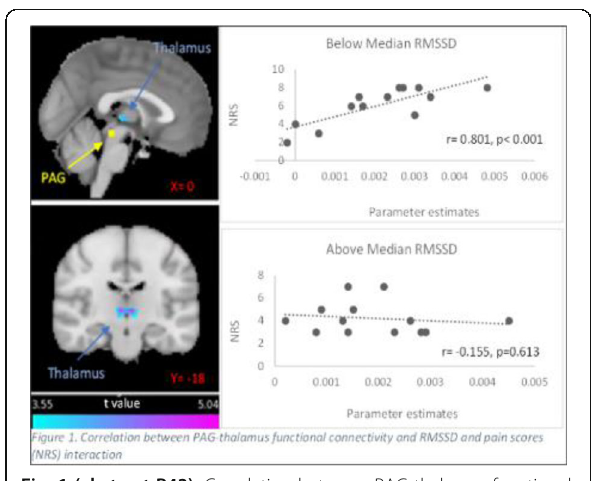
Fig. 1 (abstract P43). Correlation between PAG-thalamus functional connectivity and RMSSD and pain scores (NRS)